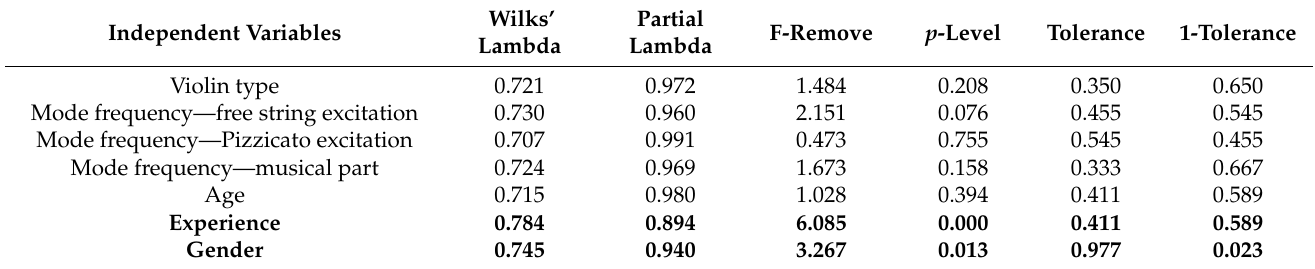
Table 7. The results of the multifactor discriminant analysis regarding the equal sonority on all four